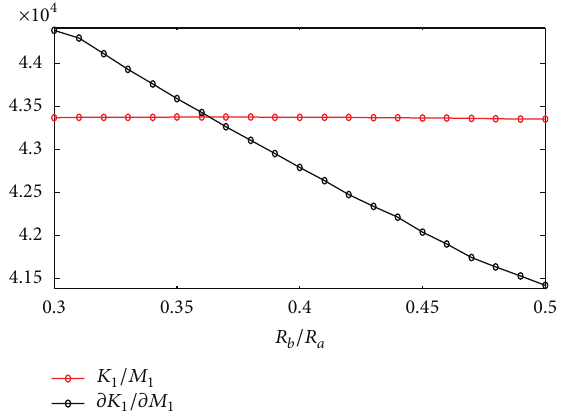
Figure 9: The value of 𝐾 1 /𝑀 1 and 𝜕𝐾 1 /𝜕𝑀 1 as functions of cur- vature ratio for an F-F-F-F shell.